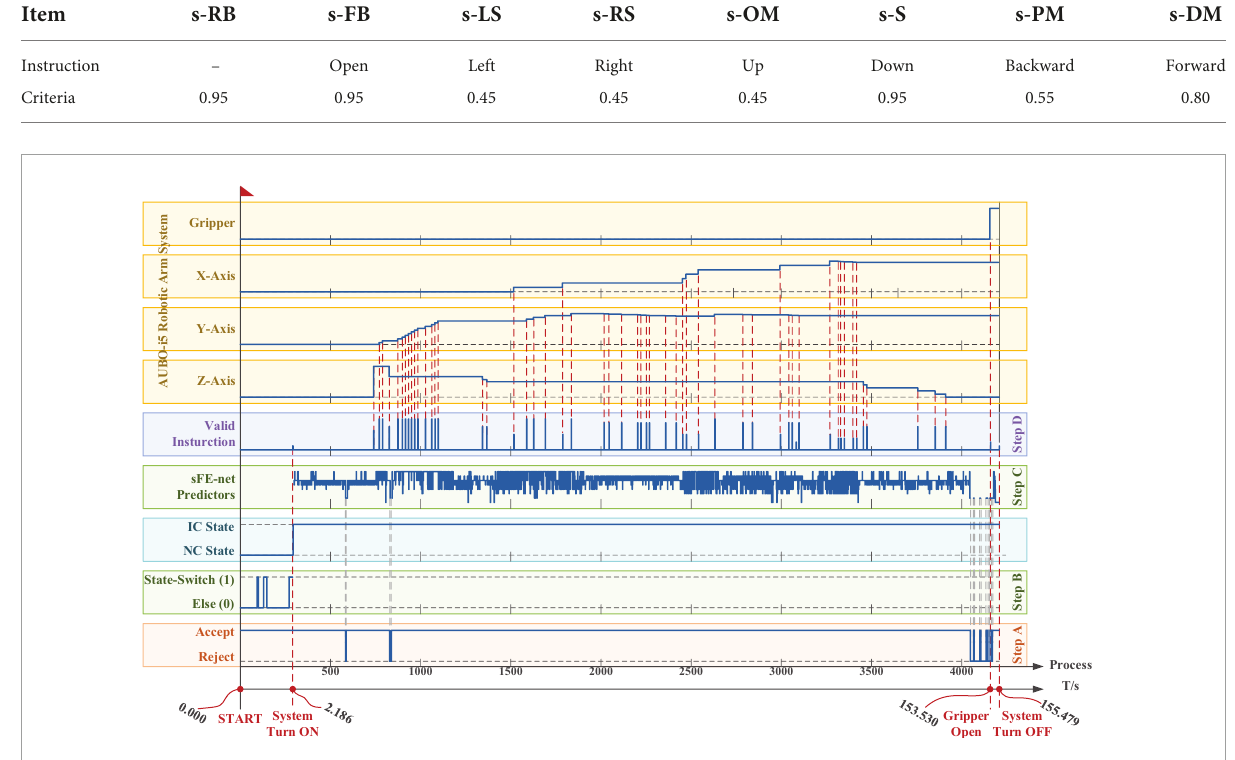
FIGURE17 The time log of a successful online manipulation in Task one performed by subject S7. From bottom to top, the first axis is the timeline, and the second axis is a counter which represents the processing of nth 100 ms EEGs. The five boxes in the lower area illustrate the algorithm results along the timeline step-by-step, and the four boxes in the upper area illustrate the systematic movement of the AUBO-i5 robotic arm. The x , y , and z axes for the robotic arm system of AUBO-i5 are consistent with Figure 4A , and the timelines for all axes and all boxes remain aligned.